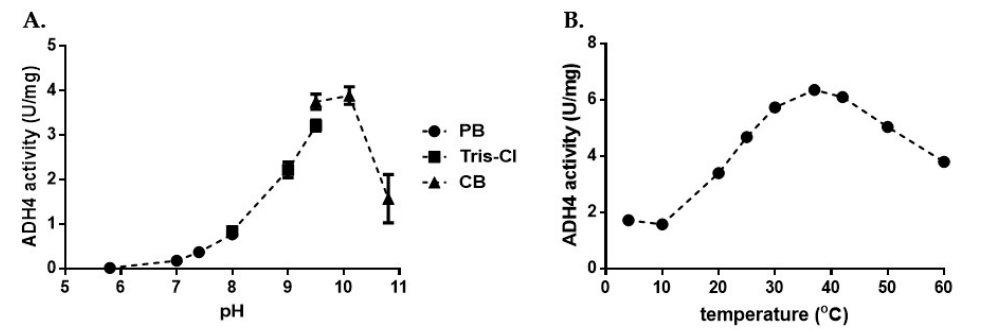
Figure 2. ( A ) Optimum pH conditions for ADH4 enzymatic activity. ADH4 enzymatic activity was assessed at room temperature under the following pH ranges: Tris-Cl: pH = 5.8–8; PB, phosphate buffer: pH = 8–9.5; CB, carbonate-bicarbonate buffer: pH = 9.5–10.8. The production of 1 µ mole of NADH was defined as 1 unit of ADH activity. ( B ) Optimum temperature of ADH4 enzymatic activity. ADH4 enzymatic activity was assessed for different temperatures at the optimum pH of 10.8 in CB buffer. Table 1. Alcohol substrate specificity of ADH4.